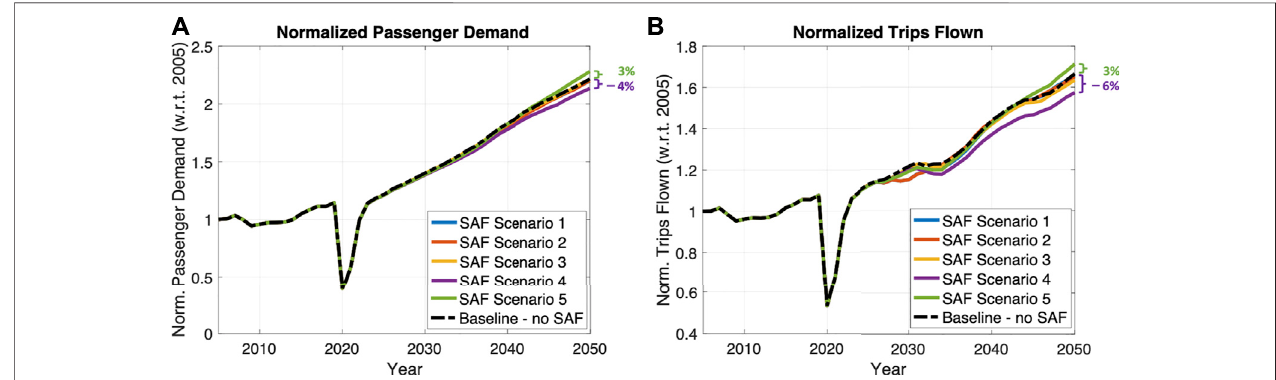
FIGURE8|(A) Normalizedpassengerdemand, (B) Normalizedtrips fl own,forSAFscenarios(consideringpassengerdemandrecoverytopre-COVID-19levelsby 2023).